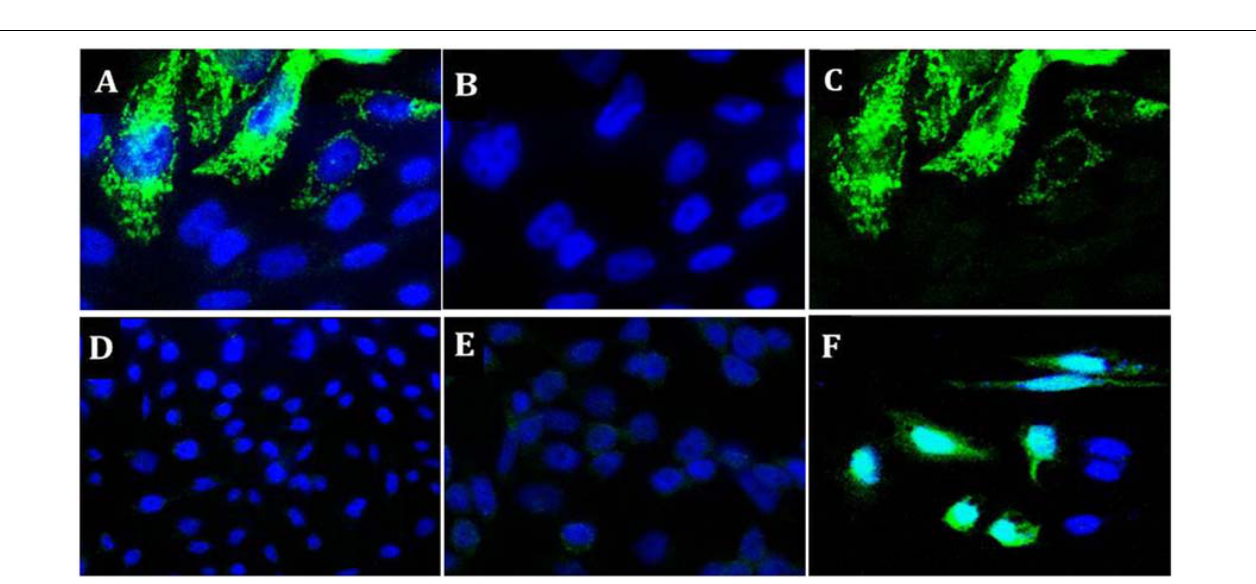
FIGURE 2 | Expression of Ag85A protein by CHO cells transfected with the pValac: Ag85A vector: (A) image of CHO cells labeled with primary (Mab DT-17/4) and secondary [goat anti-mouse IgG (H+L)] antibodies, this is a merged image of images (B,C) , (B) 4,6 (cid:48) -diamidino-2-phenylindole (DAPI) staining of the nuclei image, demonstrating intact nuclei, (C) Alexa 488 demonstrating Ag85A protein, (D) negative control: non-transfected CHO cells, (E) negative control: non-transfected CHO cells labeled with primary (Mab DT-17/4) and secondary [goat anti-mouse IgG (H+L)] antibodies, and (F) positive control: CHO cells transfected with pValac: gfp , this image is merged DAPI and GFP. 2D Images (x-y) are acquired in both depth (z-stack) using a Zeiss LSM 510 META inverted confocal laser-scanning microscope. (A–C) With 63X objective (D–F) 40 X objective.